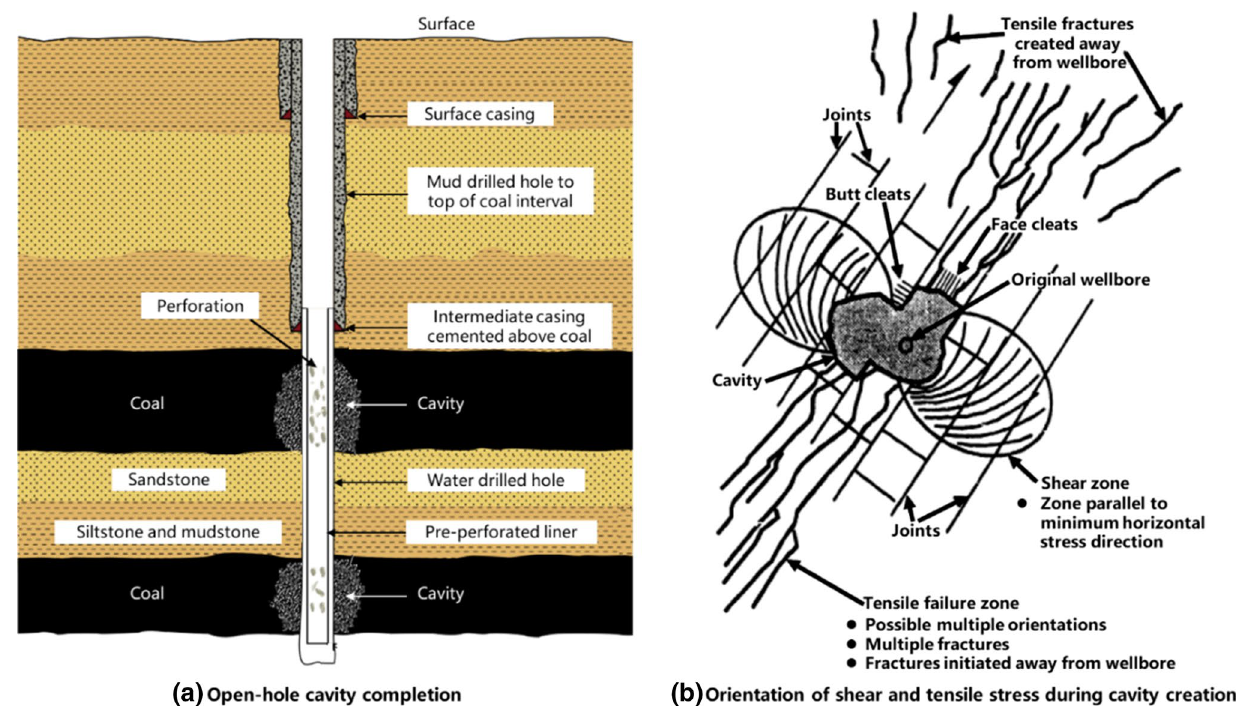
Fig. 26 Schematic of open-hole cavity completion, modified from Flores (2013) and Palmer et al.